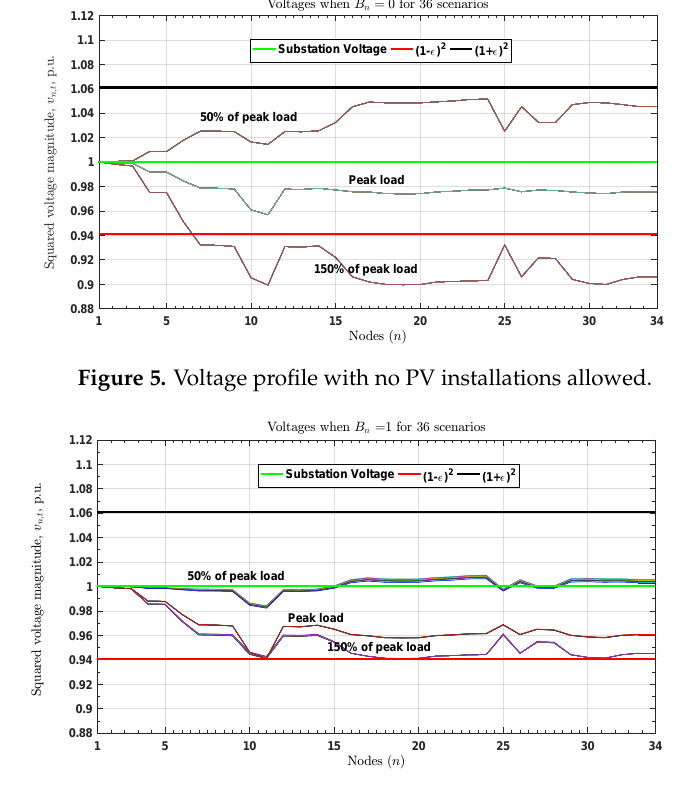
Figure 6. Voltage profile with one PV installation allowed per node ( B n = 1).